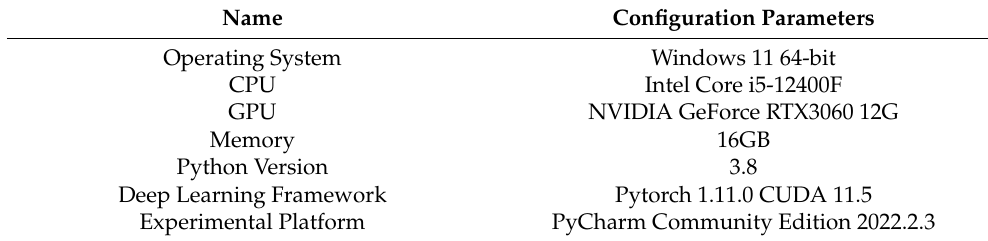
Table 3. Experimental environment.